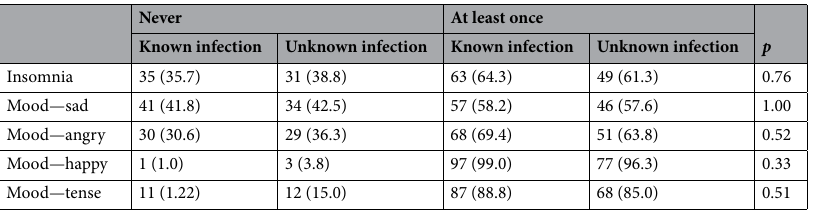
Table 6. Insomnia and mood results of seropositive participants to the Long-COVID19-survey—known vs. previously unknown infection ( n (%); Fisher’s exact test: n =